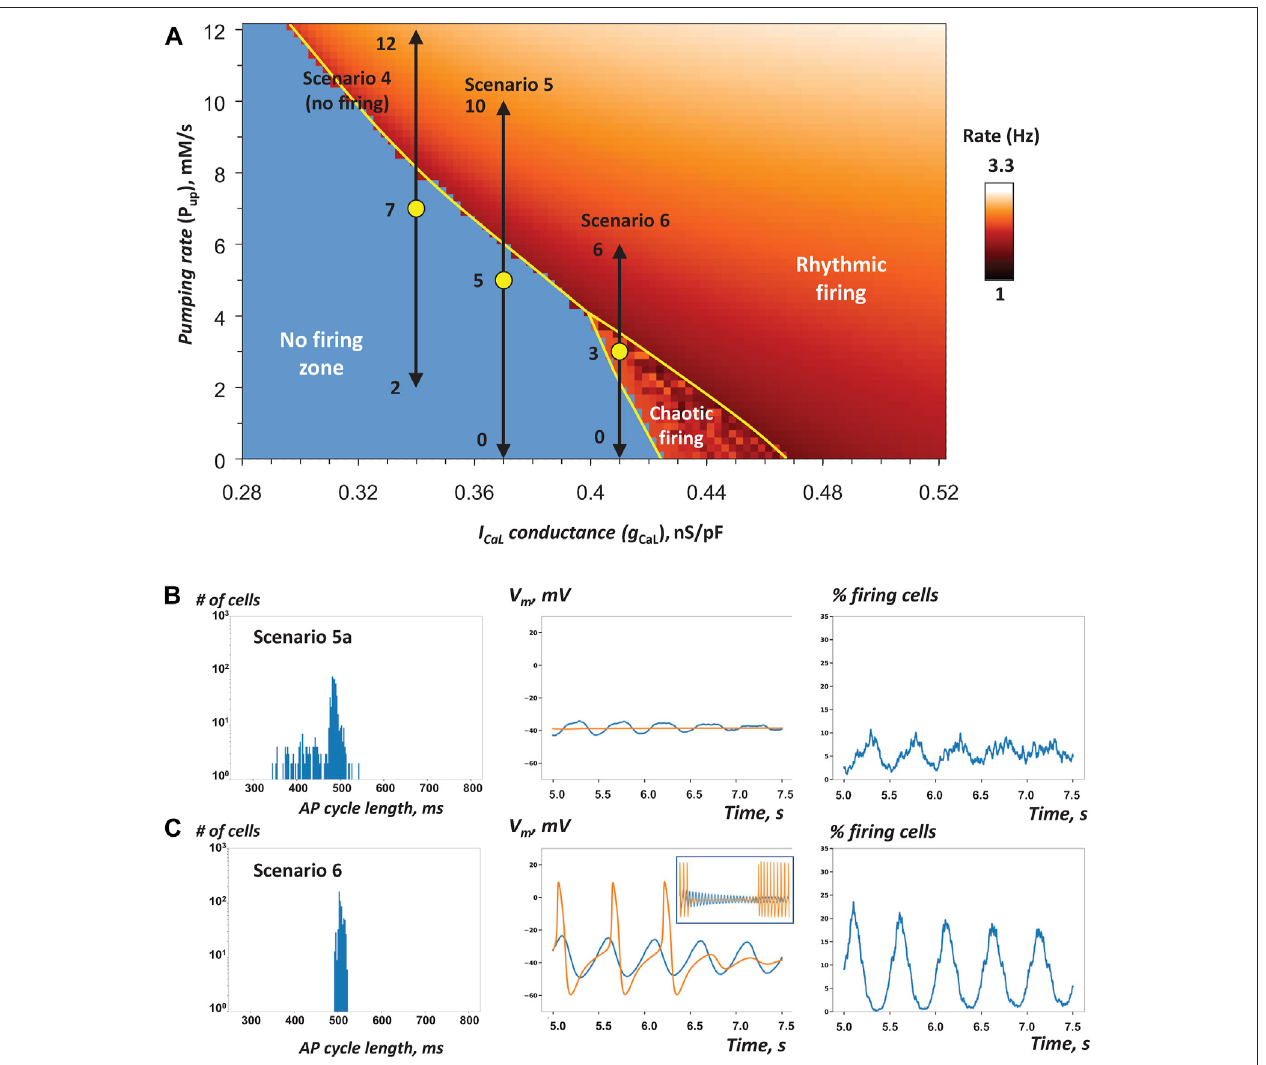
FIGURE5| Heterogeneityin P up increasesrobustnessofAP fi ringinSANtissuemodelsclosetotheedgeofstability (A) P up - g CaL bifurcationdiagramillustratingcell populations in simulations of SAN tissue function in scenarios 4, 5, and 6 ( Table 1 ) similar to Figure 3A . Yellow circles show coordinates for mean P up and fi xed g CaL values(innon- fi ringandthechaotic fi ringzones).Blackdouble-headedarrowsshowtheexact P up rangesforeachscenario.Thetissuemodelwithlow g CaL inscenario4 failed to generate AP fi ring despite a higher average P up value ( Supplementary Movie S4 ), but scenarios 5a and 6 with higher g CaL values fi red rhythmic AP ( SupplementaryMoviesS5A,S6 ). B – C :theresultsofsimulationsinscenarios5aand6.Inscenario6,weextendedthesimulationrunto25 s.InsetinpanelC(middle) shows average V m from 5 to 25 s.